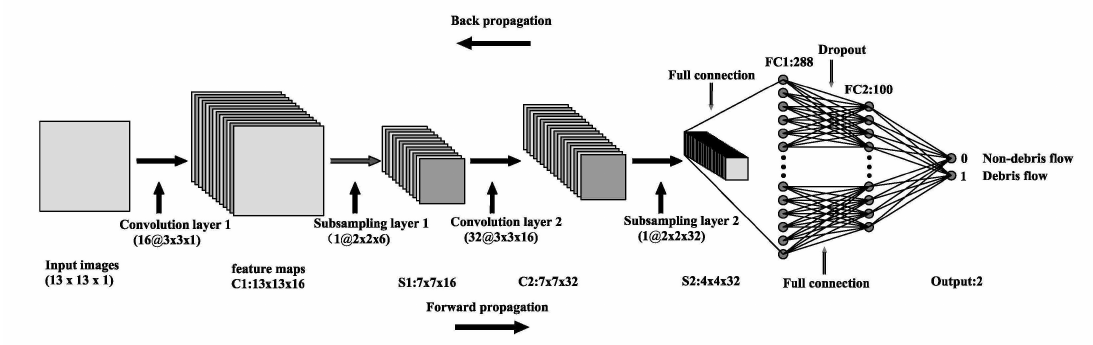
Figure 10. The SAME padding (S–CNN) structure and the principle and process of debris flow data